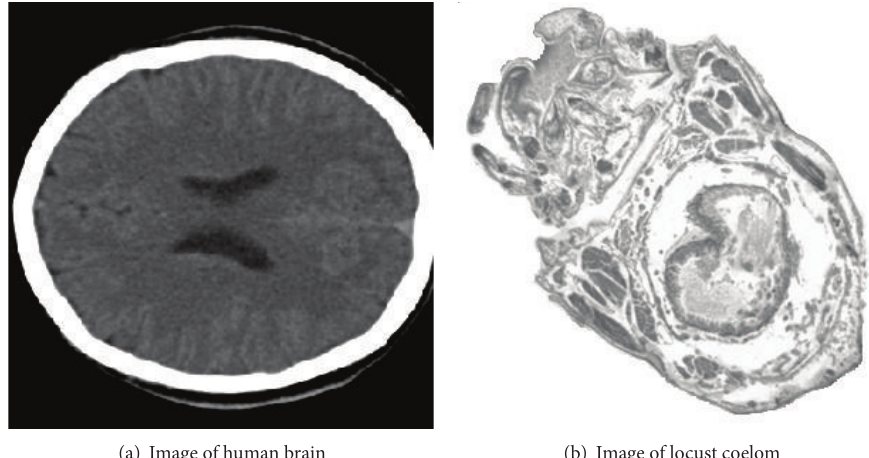
Figure 1: Original images.